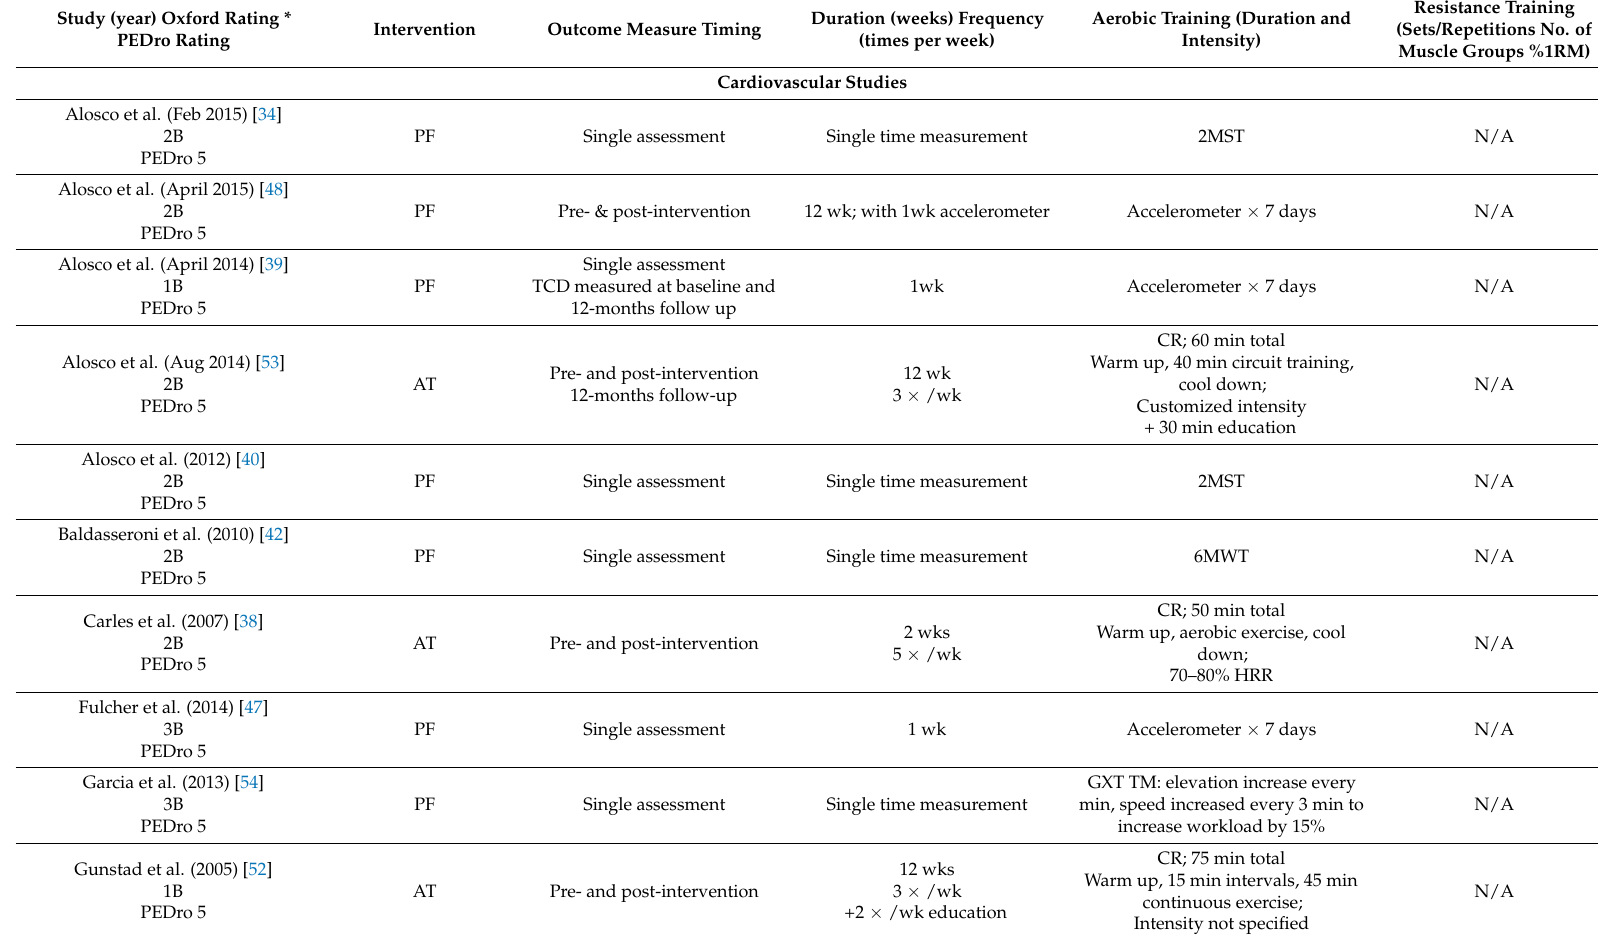
Table 2. Intervention